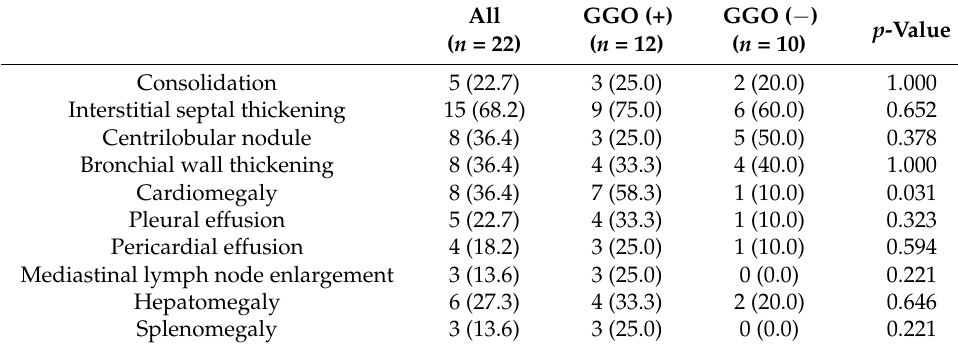
Table 2. Correlation of GGO and other abnormal chest CT findings in patients with SFTS.